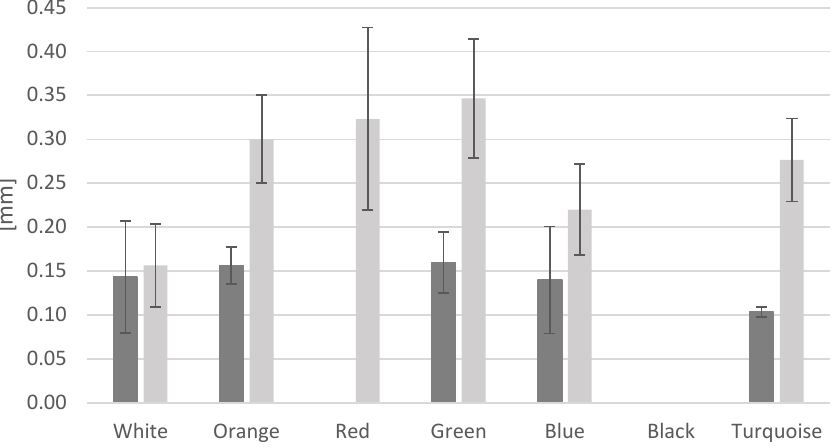
Figure 5. Comparison of the determined flatness values of seven different colored Lego bricks scanned by Artec Space Spider and the iPad Pro (2020) using TrueDepth.